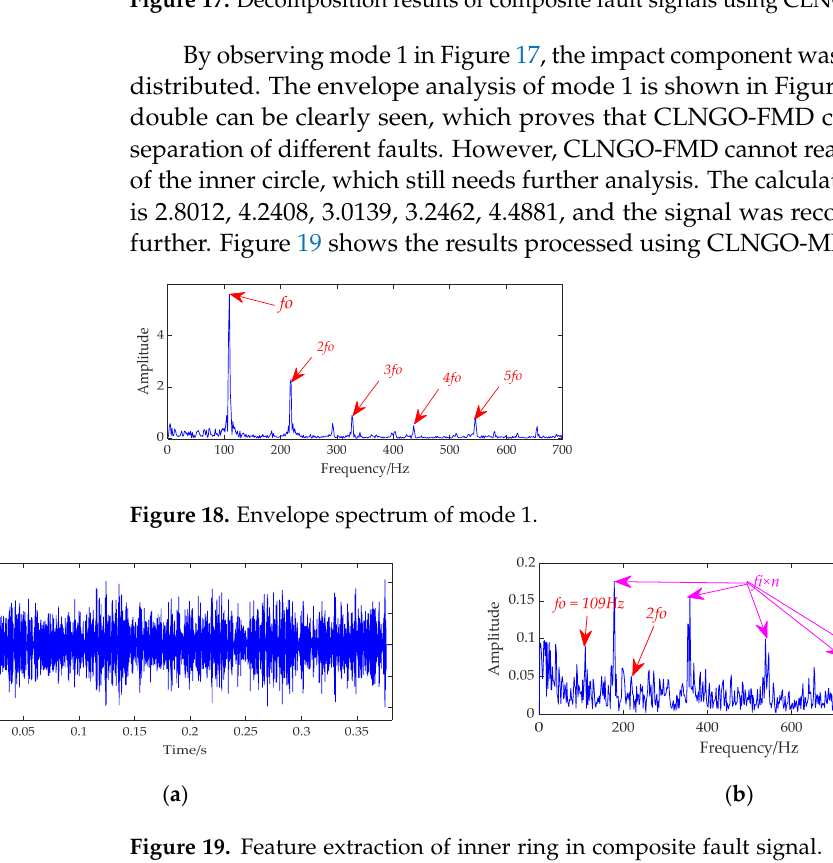
Figure 17. Decomposition results of composite fault signals using CLNGO-FMD.